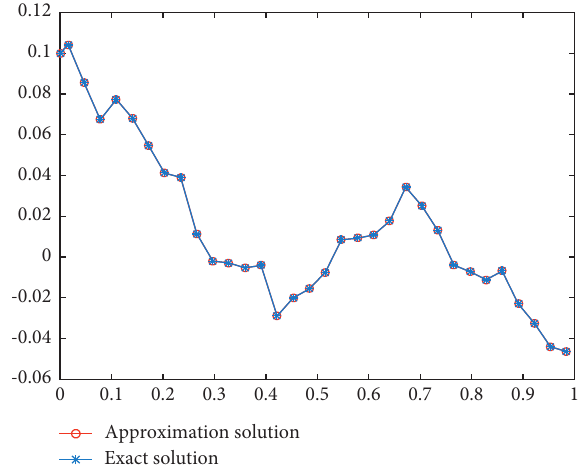
Figure 4: Simulation result of Example 2 for H � 0 . 8 and m �